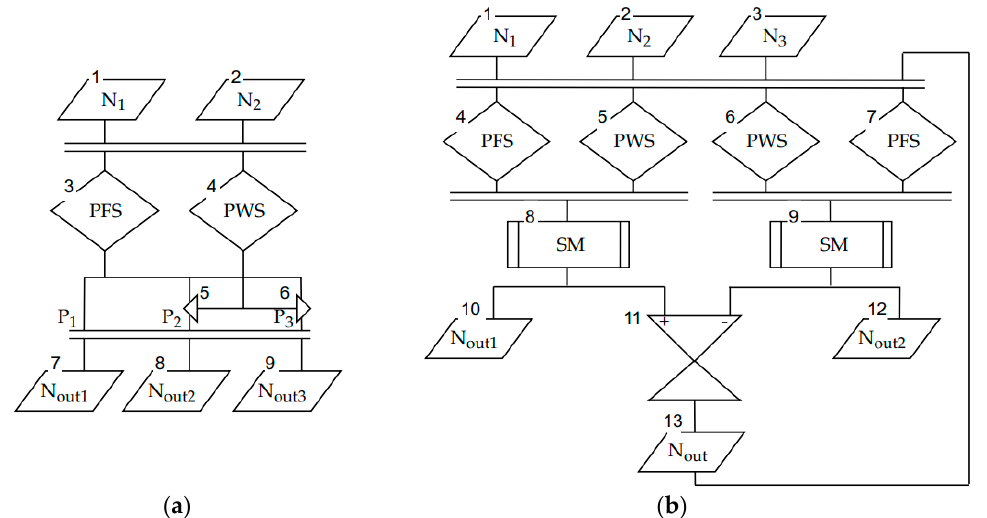
Figure 1. The scheme of the parallel bit-stream process: ( a ) multiplication process; ( b ) multiplication-division process.